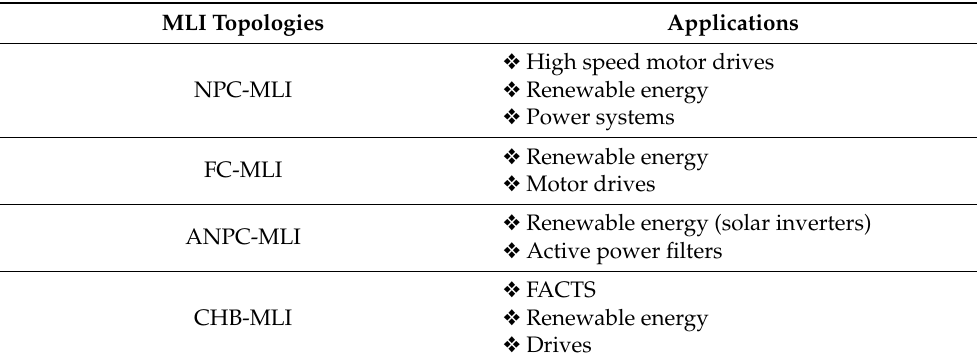
Table 4. Application of various MLI topologies in numerous power system